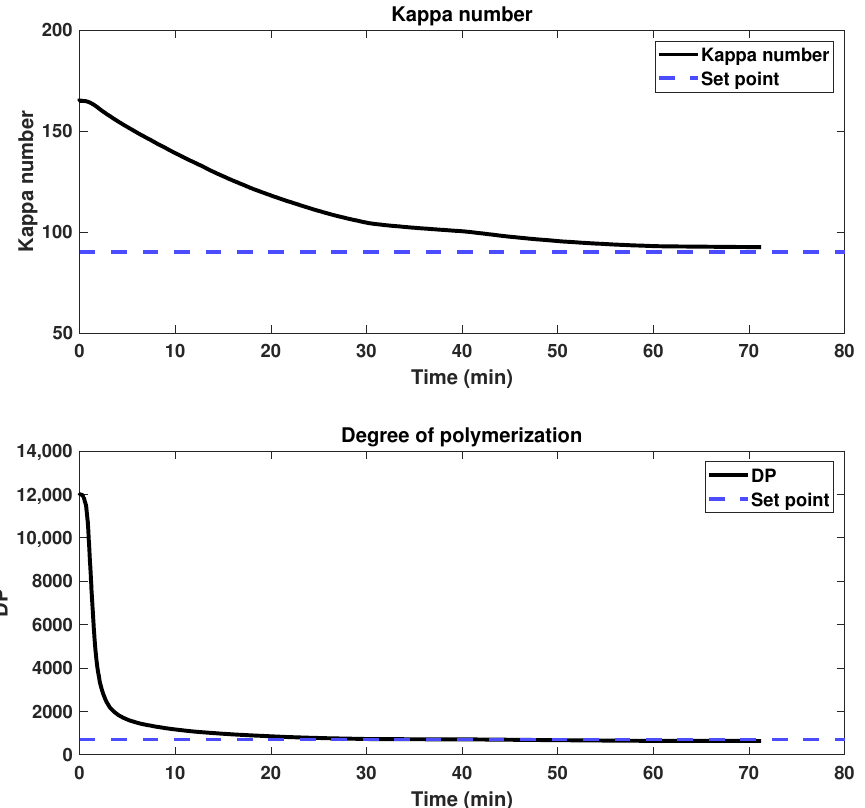
Figure 9. Trajectories of the Kappa number and degree of polymerization as obtained from the closed-loop